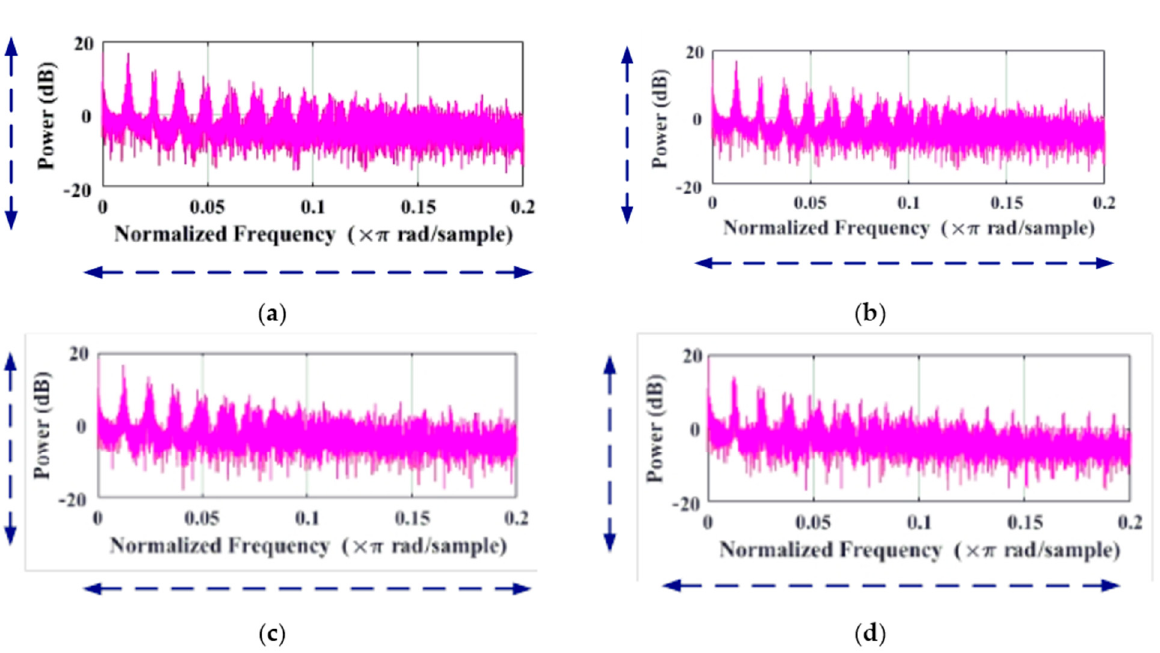
Figure 8. MCRSVPWM simulation results of motor current spectrum for M a values: ( a ) M a = 0.2, ( b ) M a = 0.5, ( c ) M a = 0.7, and ( d ) M a = 0.9.